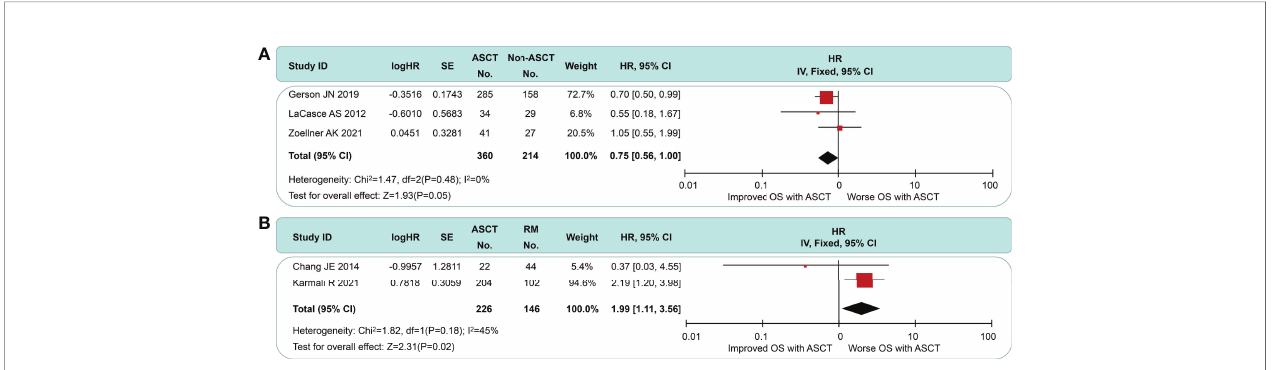
FIGURE 6 | Meta-analysis results of overall survival: (A) Subgroup analysis for patients with non-intensive induction. (B) Survival analysis between patients undergoing autologous stem cell transplantation and rituximab.